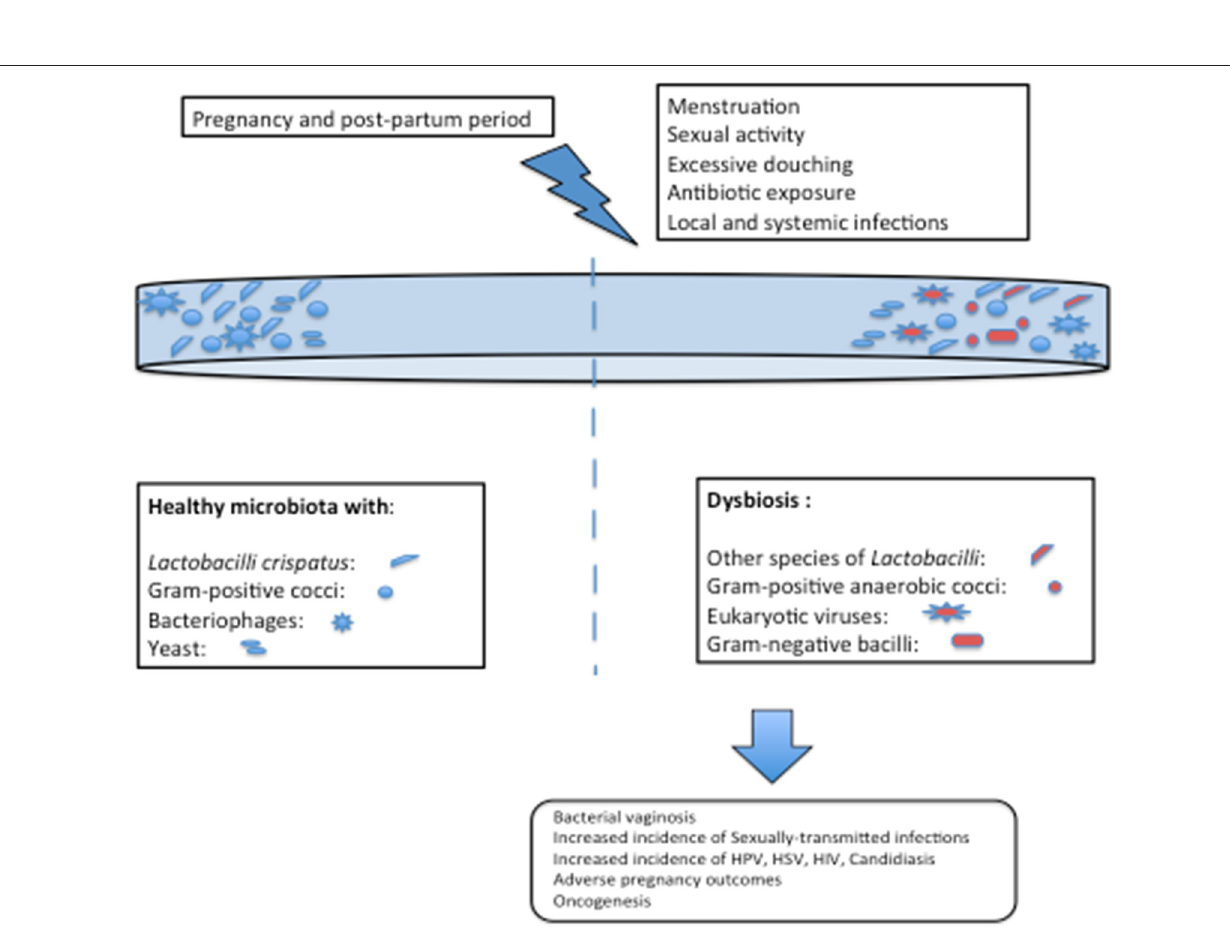
Frontiers in Public Health |